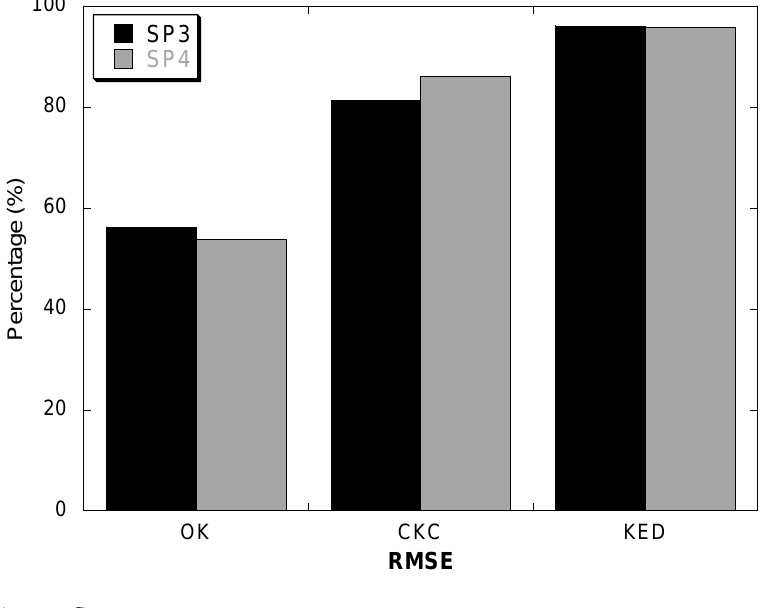
Figure 12. Percentage of pixels with RMSE between OK, CKC y KED with respect to the high-resolution LAI reference map lower than 1.0 for the SP3 (top) and SP4 (bottom) sampling